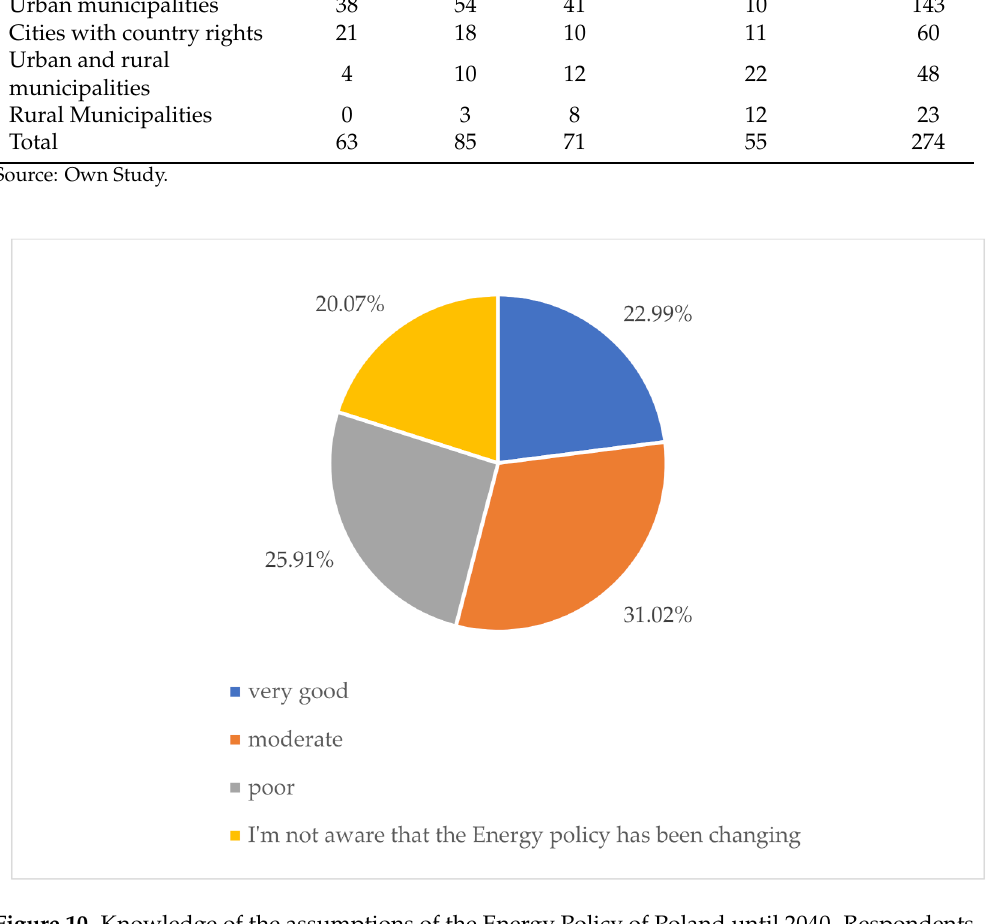
Figure 10. Knowledge of the assumptions of the Energy Policy of Poland until 2040. Respondents could select only one answer. Source: own